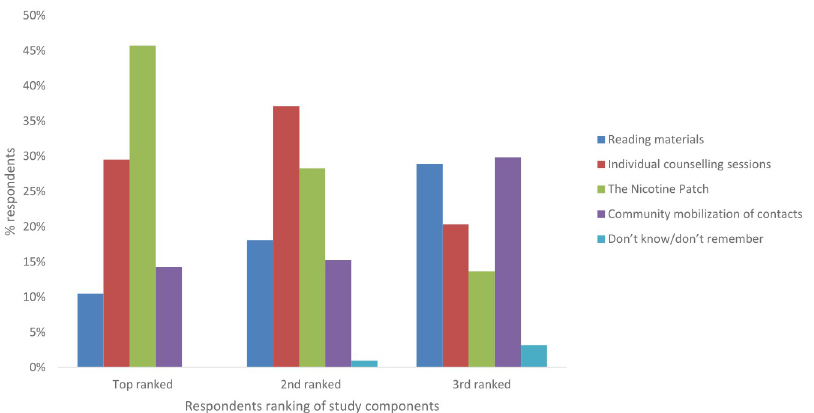
Fig 1. Participants preference for study components.